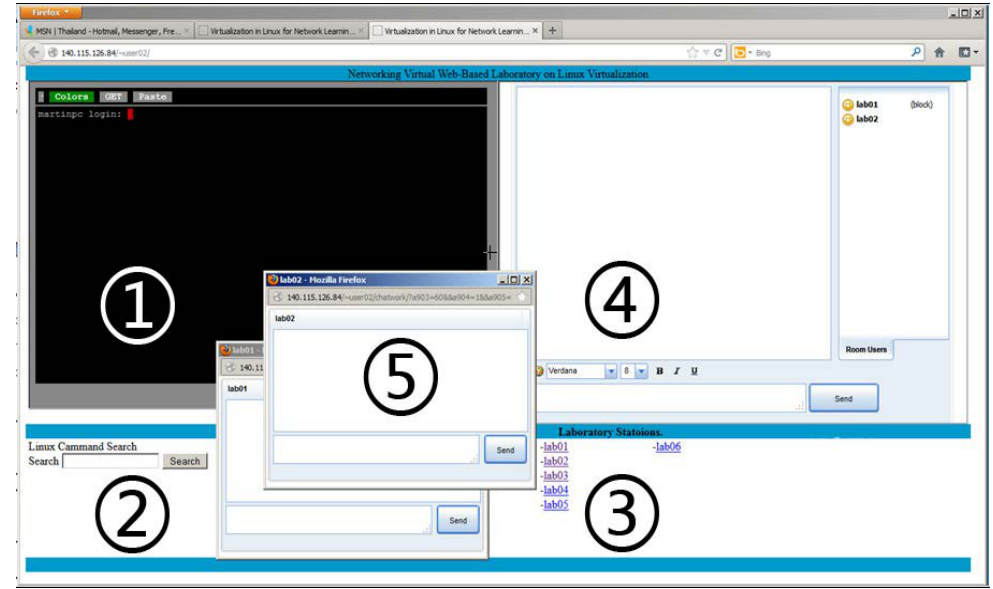
Figure 3. NVBLab Web GUI: 1) Web-terminal; 2) command search window; 3) laboratory materials; and 4), 5) group chat window and individual chat